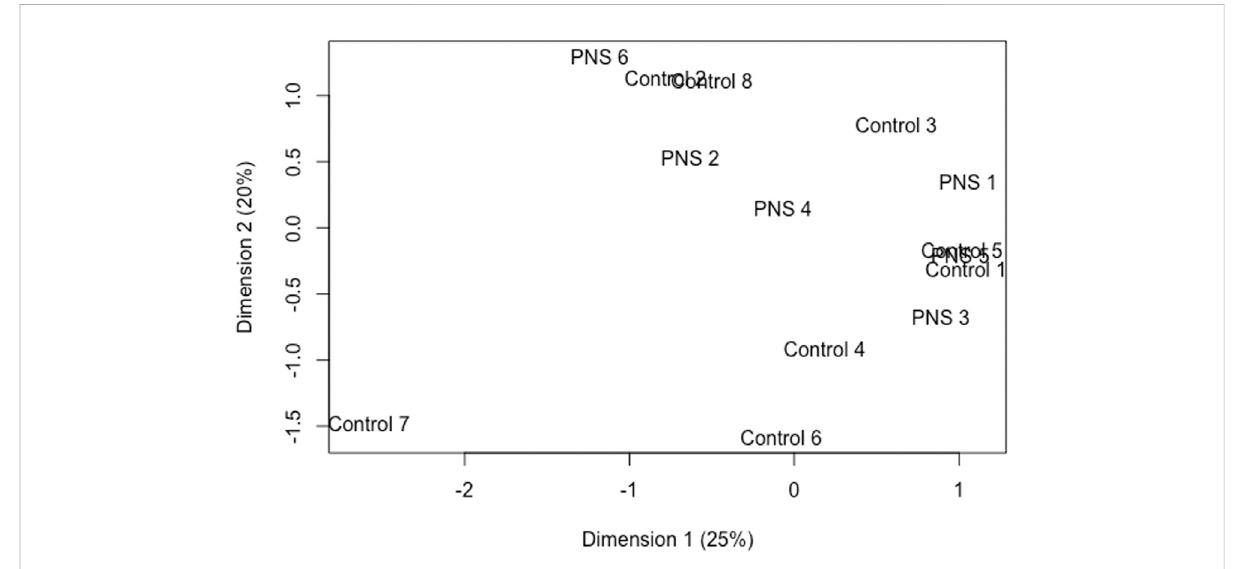
FIGURE 3 Multidimensional scaling plot utilizing normalized read counts to plot distances between expression pro fi les of amygdala tissue of 5-year-old prenatally stressed (PNS) Brahman cows relative to Control